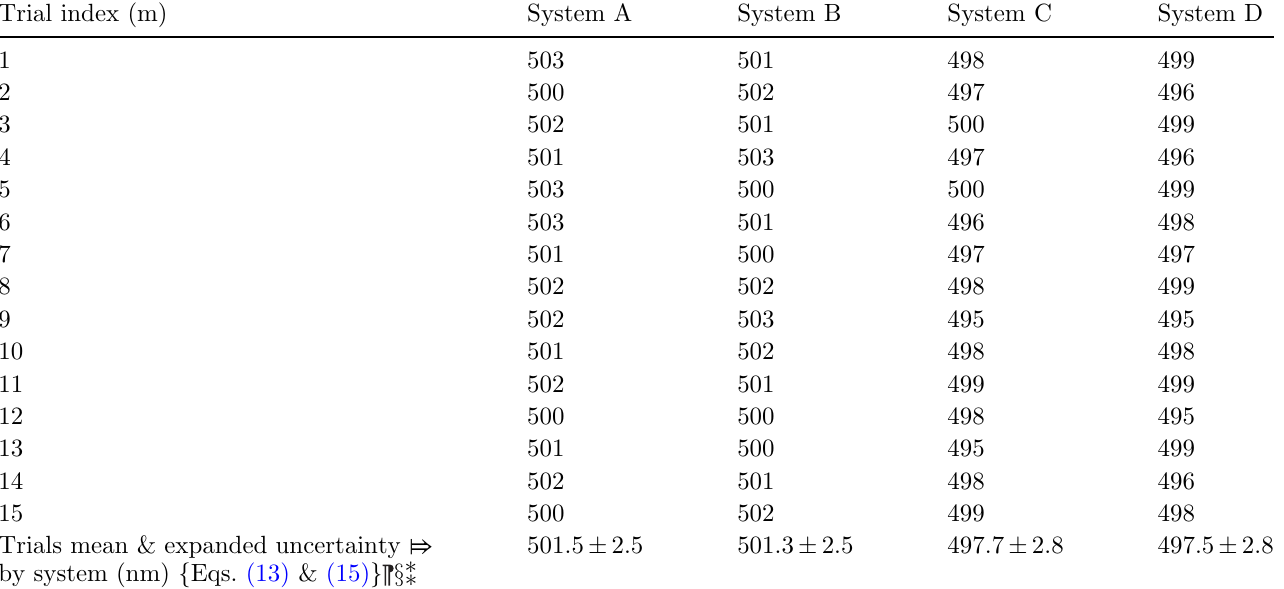
Table 3. Example 3. FAC-1; 4 measurement systems; Bias trials, Consensus standard = (502 ± 4) nm, (measurement unit = nm.).